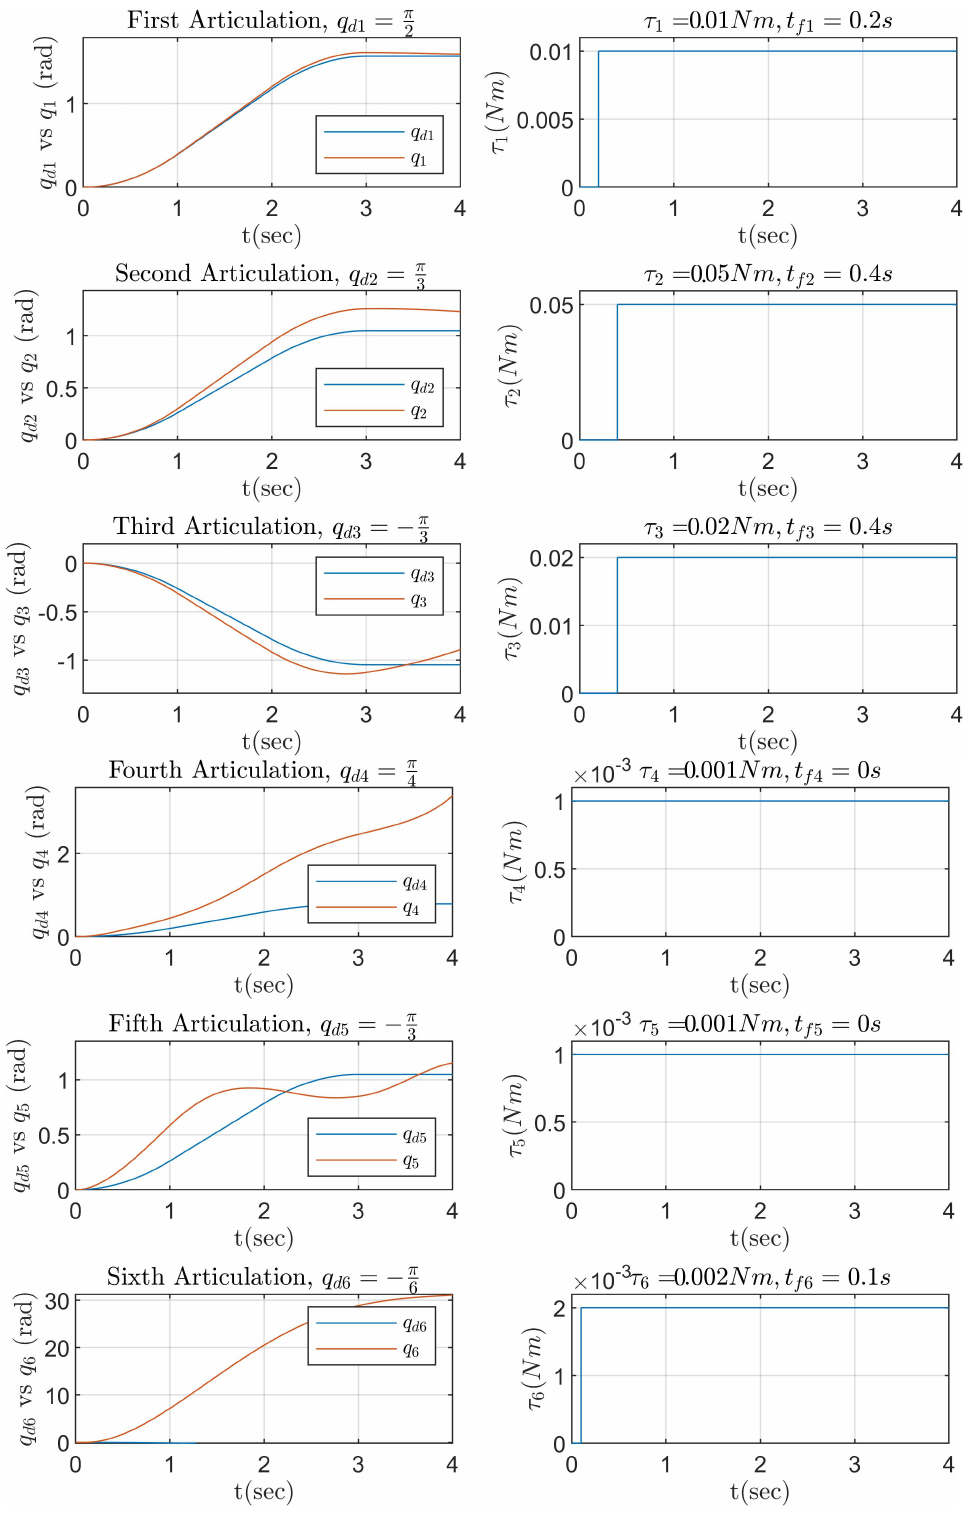
Figure 4. Numerical simulation of CTC with